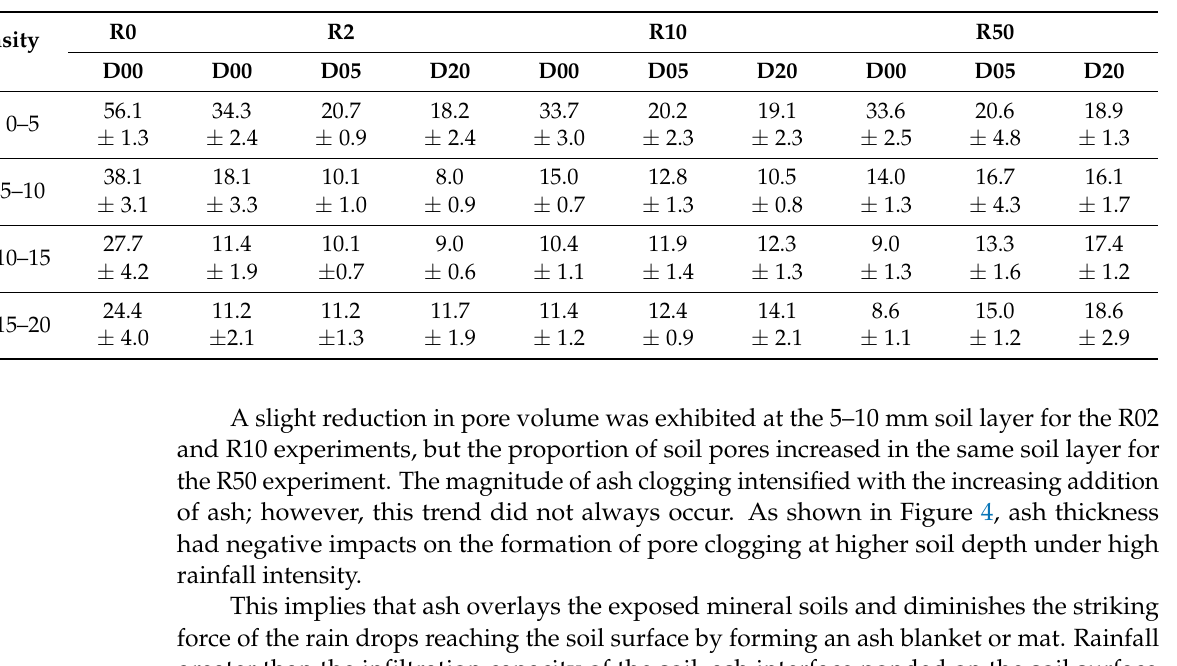
Table 3. Volume density of soil pore with ash treatment and rainfall